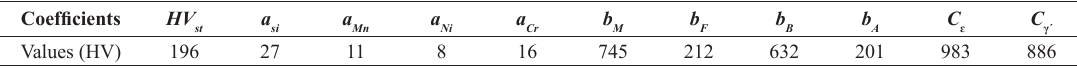
Table 2 - Chemical composition of SCr420H steel Chemical elements Fe C Si Mn Cr P S N Mo